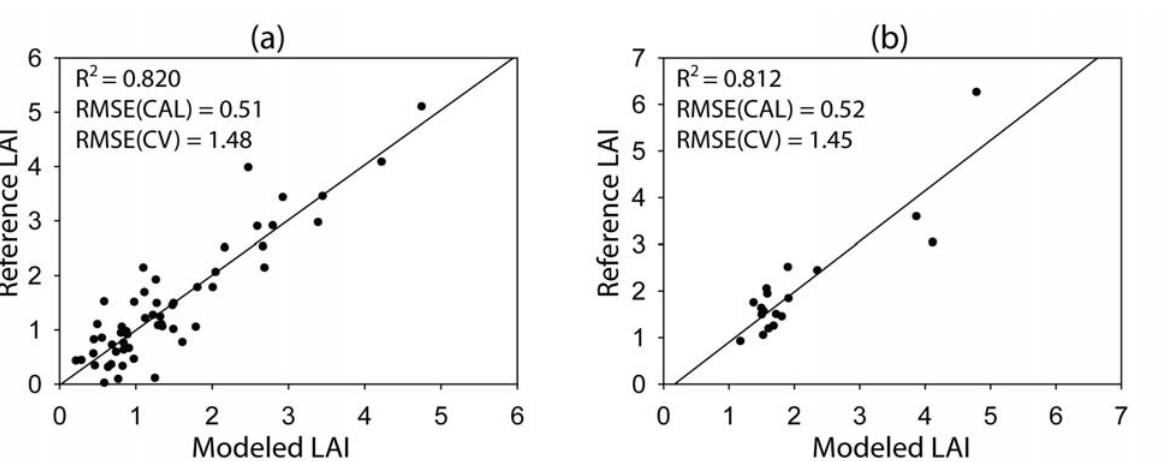
Figure 5. LAI estimation using the regression tree approach for ( a ) the Monticello, UT Site, and ( b ) the Monument Valley, AZ Site. The R 2 and RMSEs from calibration (CAL) and cross-validation (CV) are summarized in the